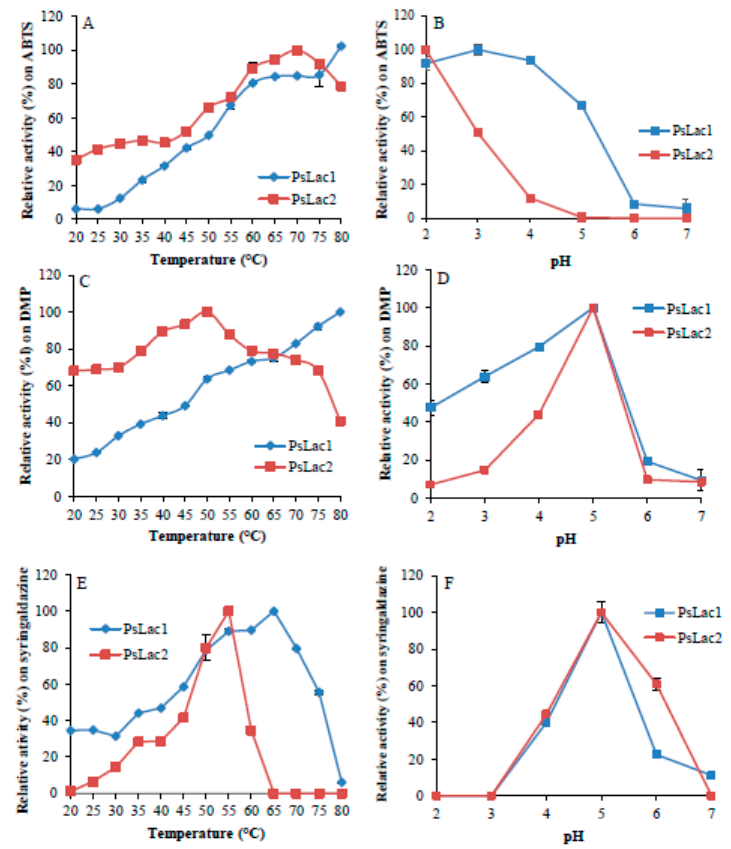
Figure 3. Temperature and pH dependence of Ps Lac1 and Ps Lac2 activity on di ff erent substrates. Values were calculated as a percentage of maximum activity (set to 100%) at optimum temperature and pH. The oxidation of ABTS ( A , B ), 2,6-dimethoxyphenol (DMP) ( C , D ), and syringaldazine ( E , F ) (5 mM each) was determined for the temperature curve in 20 mM of tartrate bu ff er pH 4.0, and for the pH curve at 30 ◦ C. Each data point (mean +/ − standard deviation) is the result of triplicate